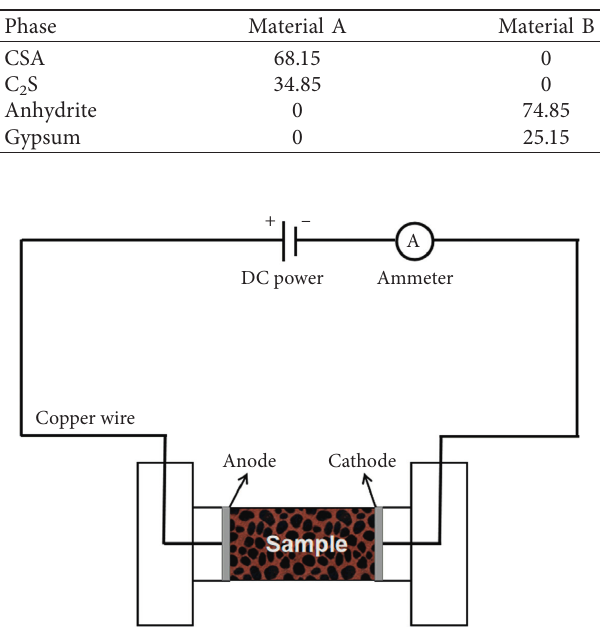
Table 1: Mineralogical composition and content of materials A and B in HWBM (%).